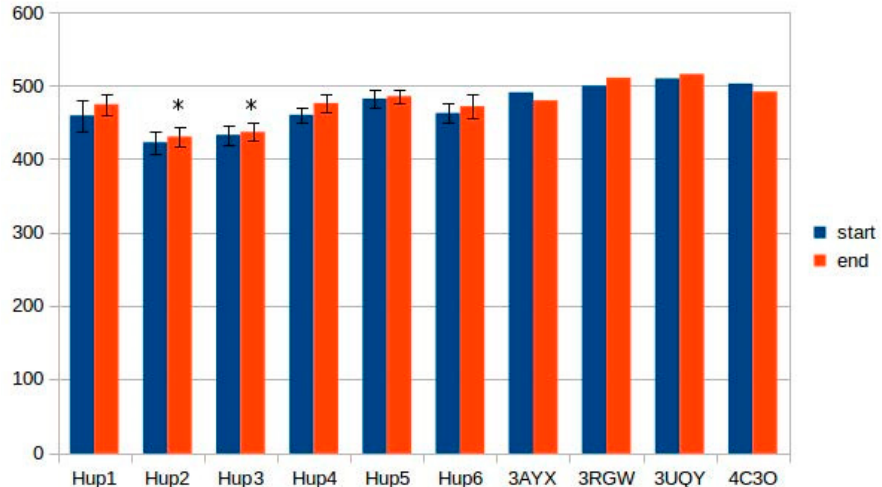
Figure 9. Number of hydrophobic contacts in the large subunits of HupSL hydrogenases. Hup1 -HupSL from Tca. roseopersicina ; Hup2 -HupSL from Rba. capsulatus ; Hup3 -HupSL from Rba. sphaeroides ; Hup4 -HupSL from Rps. palustris ; Hup5 -HupSL from Rvi. gelatinosus ; Hup6 -HupSL from Rsp. rubrum ; 3AYX -HoxKG from H. marinus ; 3RGW -HoxKG from R. eutropha ; 3UQY -HyaAB from E. coli ; 4C3O -HydAB from Sa. enterica. Start-models (structures) before energy minimization; end-models (structures) after energy minimization. The data are represented as mean ± 2 ∙ × SD. Significantly low results (ranges not overlapping with the others in the subgroup) are marked by asterisks.